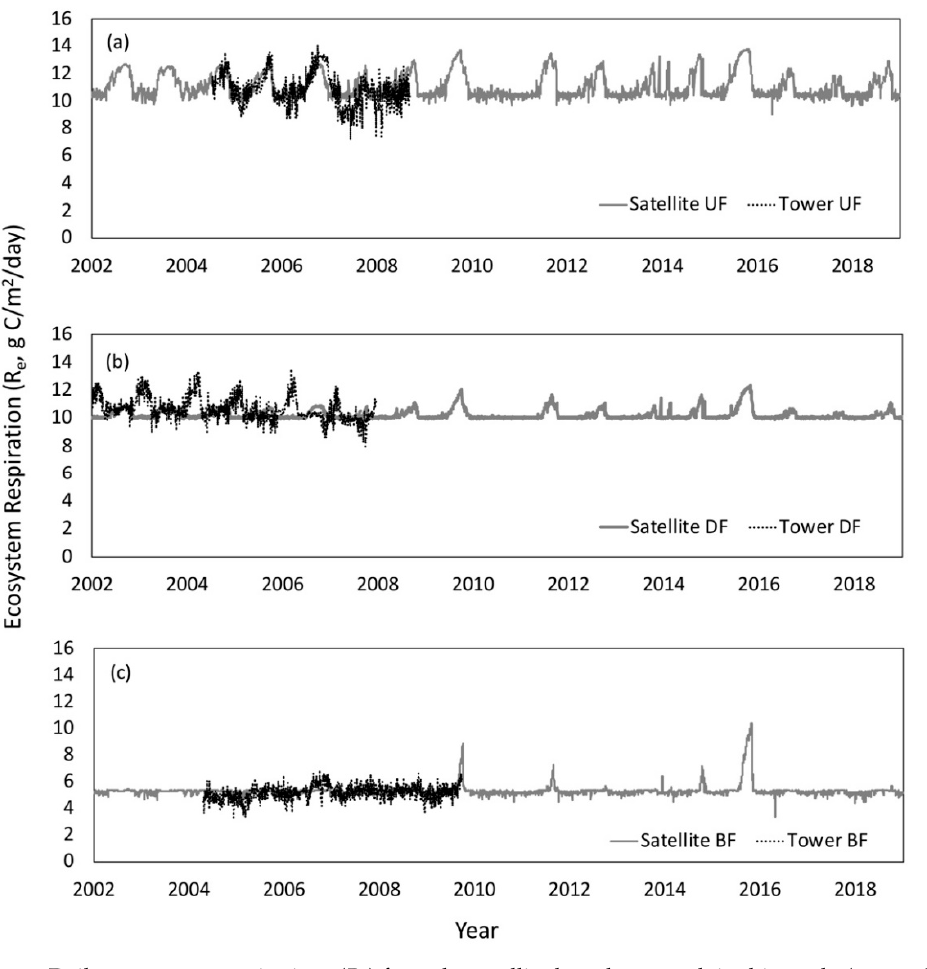
Figure 6. Daily ecosystem respirations ( R e ) from the satellite-based approach in this study (gray solid line) and tower measurements (black dashed line) in three cases of flux tower sites: ( a ) undrained forest (UF), ( b ) drained forest (DF), and ( c ) burned forest (BF).